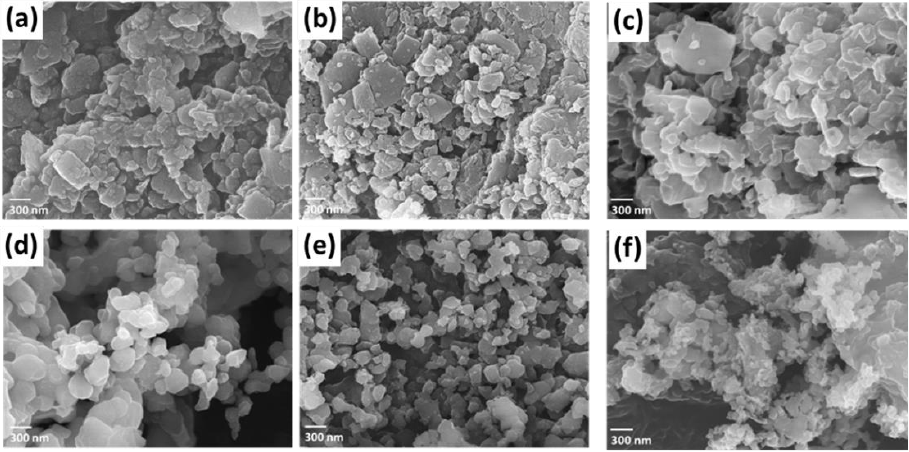
Figure 7. SEM images of ( a ) Ca0.97Mg0.03-MOF, ( b ) Ca0.97Mg0.025Al0.005-MOF, ( c ) Ca0.97Mg0.015Al0.015-MOF, ( d ) Ca0.97Mg0.03-MOF-O, ( e ) Ca0.97Mg0.025Al0.005-MOF-O, and ( f ) Ca0.97Mg0.015Al0.015-MOF-O.